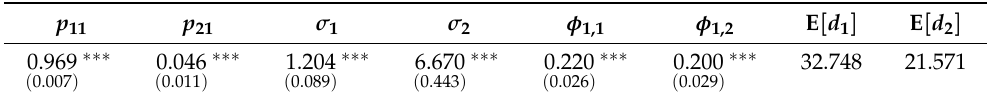
Table 4. MS(2)-AR(1) model estimation.